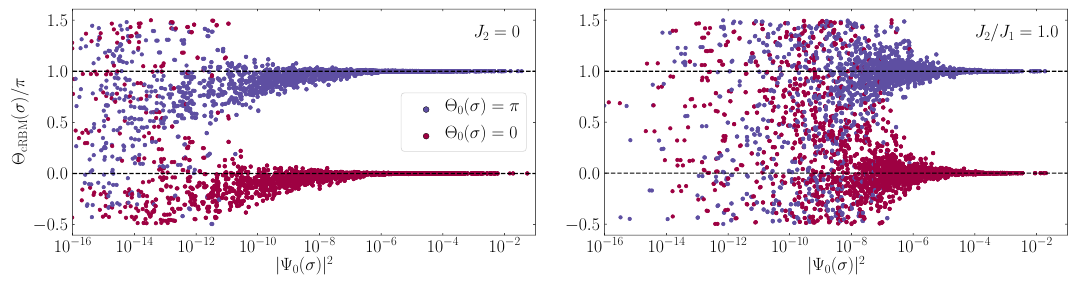
( σ ) phases of the optimal cRBM state with α = 1 for all the spin Figure 7: Θ c cRBM = 0 and momentum k = 0 (for N = 20 sites). The phases configurations with S z tot ( σ ) | 2 of the configurations. Results are plotted as a function of the exact weight | Ψ 0 = 0 (left panel) and J / J = 1 (right panel) are shown. The colors of the dots for J 2 2 1 denote the phase of the exact ground-state wave